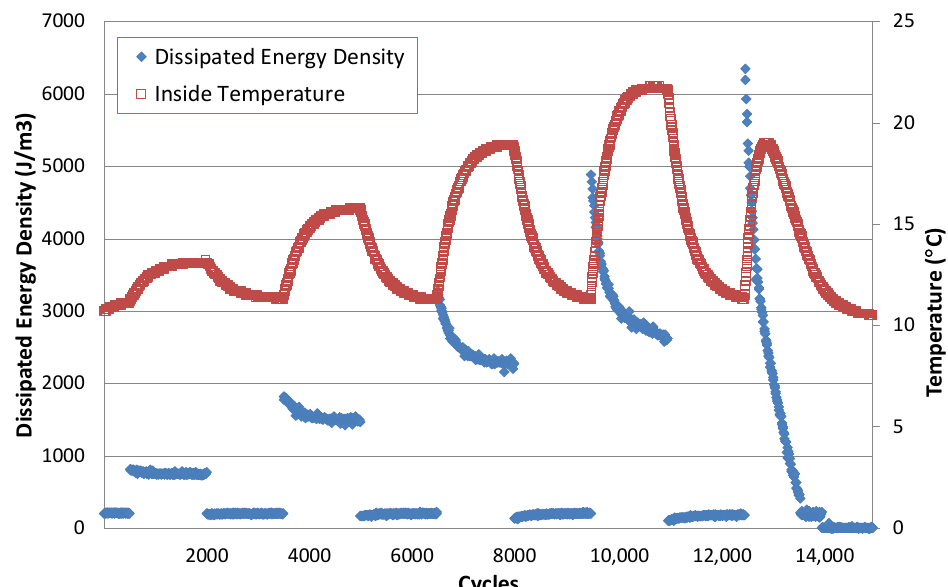
Figure 7. Evolution of dissipated energy density and temperature with number of cycles. EBADE test carried out at 10 °C and 10 Hz.